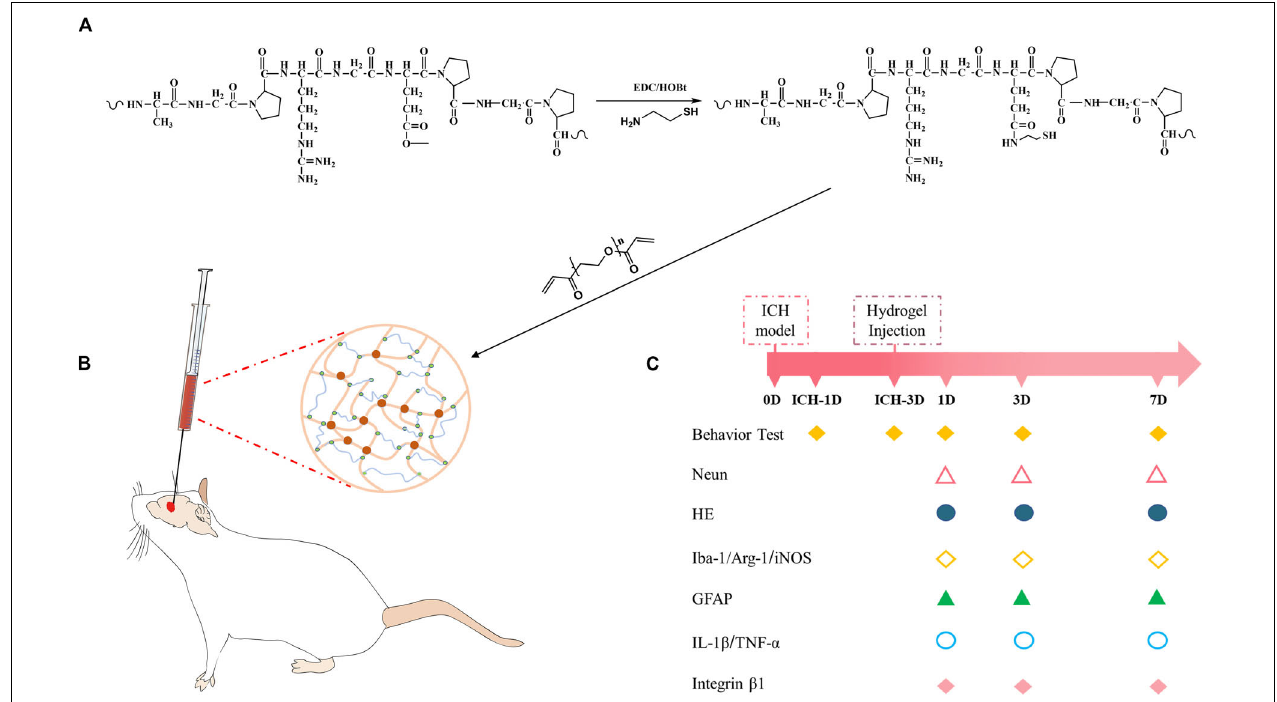
FIGURE 1 | (A) Synthesis pathway of thiolated gelatin. (B) Schematic presentation of gelatin hydrogel injection into the lesion site in a mouse model of ICH. (C) Experimental protocol and